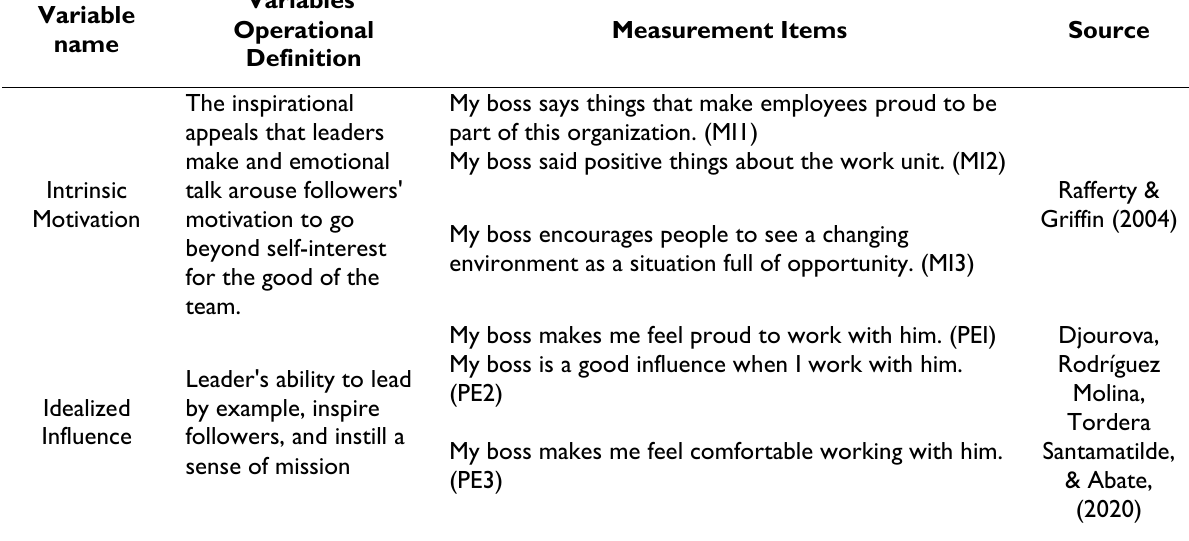
Table 1. Operational Definition of Variables